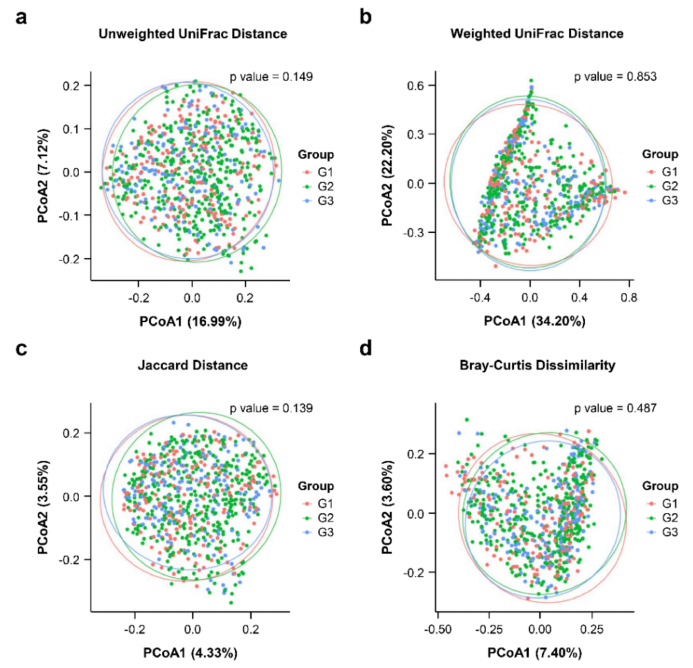
Figure 3. Beta-diversity of microbial taxa. Principal coordinate analysis (PCoA) plots representing the β -diversity for ( a ) unweighted UniFrac distance, ( b ) weighted UniFrac distance, ( c ) Jaccard distance, and ( d ) Bray–Curtis dissimilarity comparing subjects by PSA. Each point represents an individual subject. Statistics were calculated using pairwise PERMANOVA with 999 permutations. Ellipses represent the 95% confidence interval for each